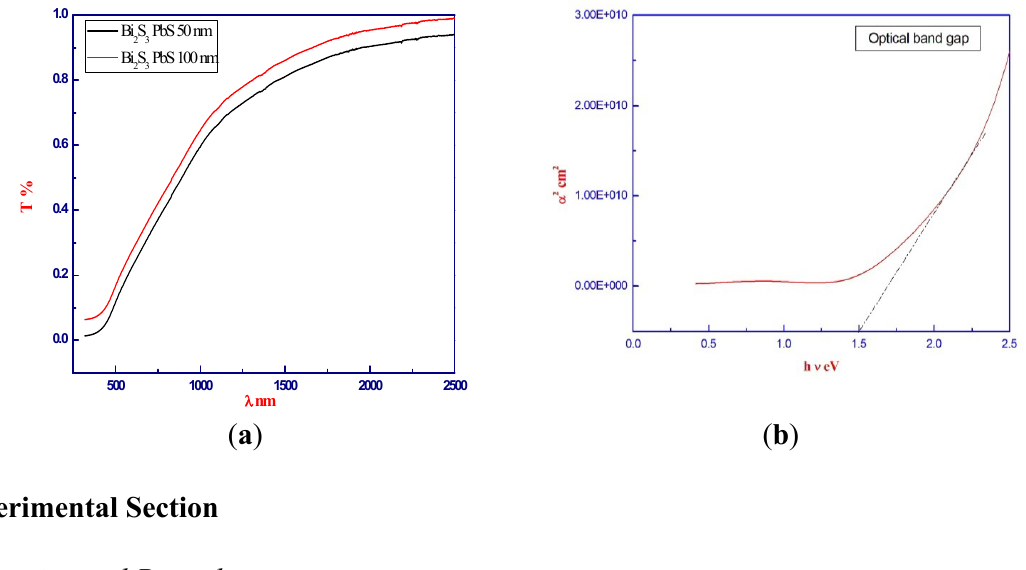
S )(PbS) thin films, ( a ) Typical transmission curves; 2 3 g